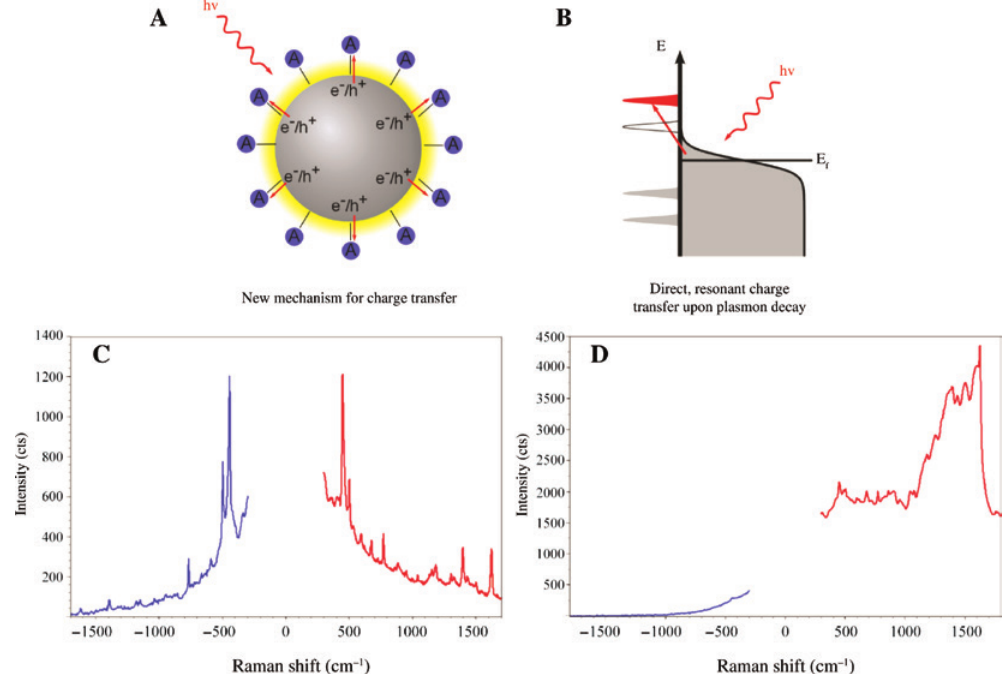
Figure 4: Formation of an alternative pathway of resonant energy transfer for plasmonic charge carriers into the high-energy states of the molecular